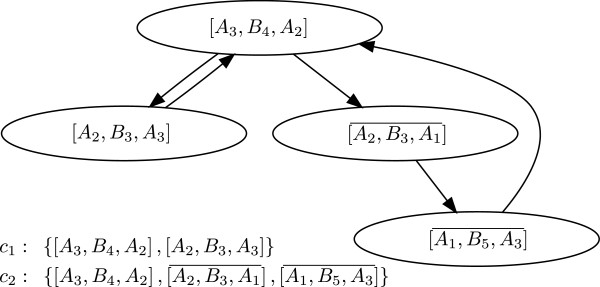
Path graph for the critical fragment of the reversible substrate inhibition mechanism. The path graph Φ and the detected cycles, that do not have repeated species as starting nodes of paths, of the critical fragment S3=1,2,35,3,4 shown in Figure 2. Only two cycles c1 and c2 that are reported previously in [3] are found.